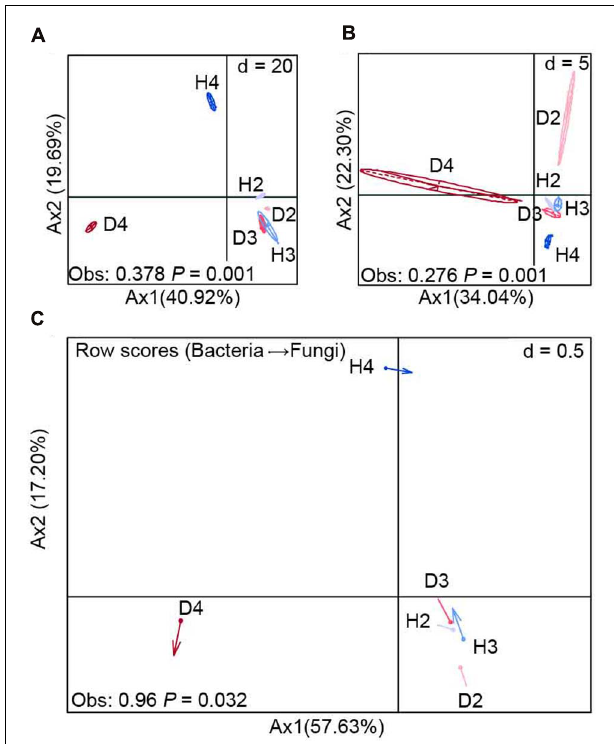
FIGURE 2 | Between-class analysis of bacterial (A) and fungal (B) communities (OTU level) and their co-inertia (C) . H2, soils obtained from 2-year-old healthy AG plants; D2, soils obtained from 2-year-old diseased AG plants; H3, soils obtained from 3-year-old healthy AG plants; D3, soils obtained from 3-year-old diseased AG plants; H4, soils obtained from 4-year-old healthy AG plants; D4, soils obtained from 4-year-old diseased AG